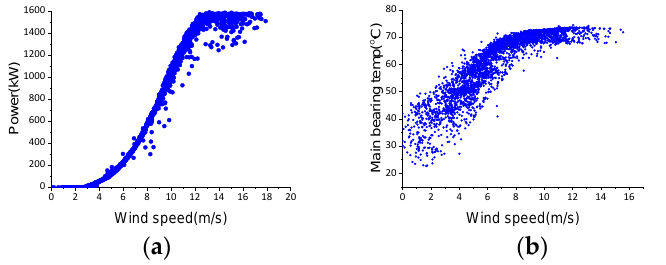
Figure 1. WT in normal state: ( a ) active power – wind speed; ( b ) main bearing temperature – wind speed.